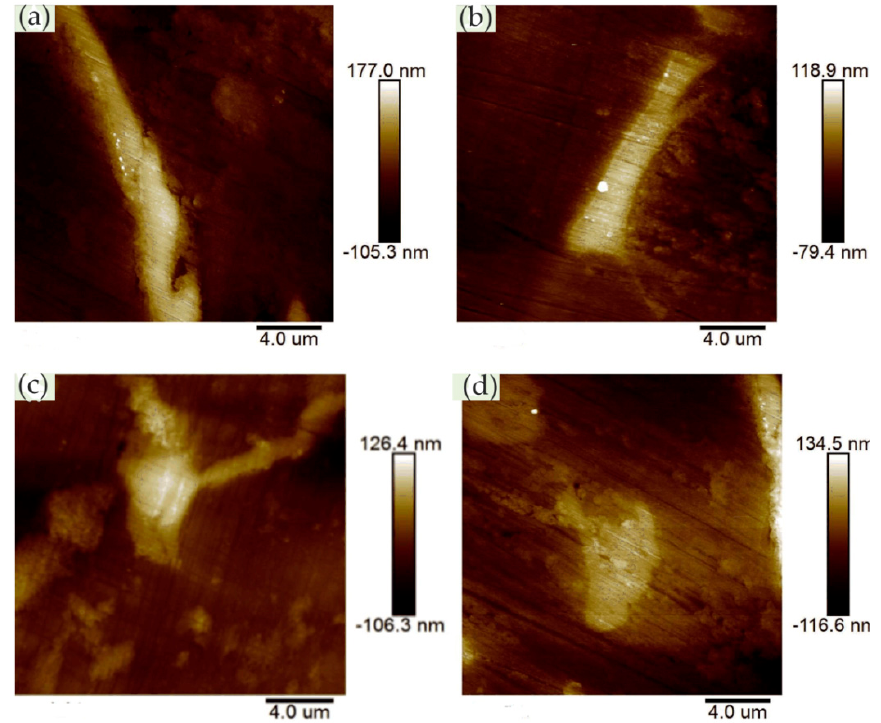
Figure 18. Typical in situ surface images for different intermetallics after immersion in 0.1 mol/L NaCl solution for 60 min: ( a ) acicular-like RE phase, ( b ) rod-like RE phase, ( c ) granular RE phase, and ( d ) dispersed granular b-Mg17Al12 in AZ91 alloy with 1.0% (La,Ce) mischmetal (MM) addition. Reprinted with permission from Reference [52]; copyright 2019 Elsevier Ltd.